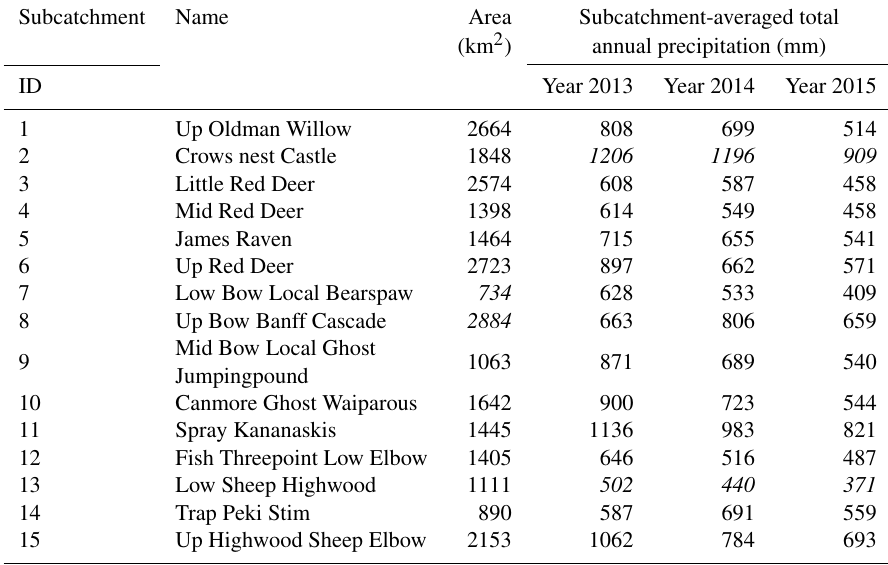
Table 2. Description of subcatchments in the study area. Italics is used to highlight maximum and minimum values in the corresponding